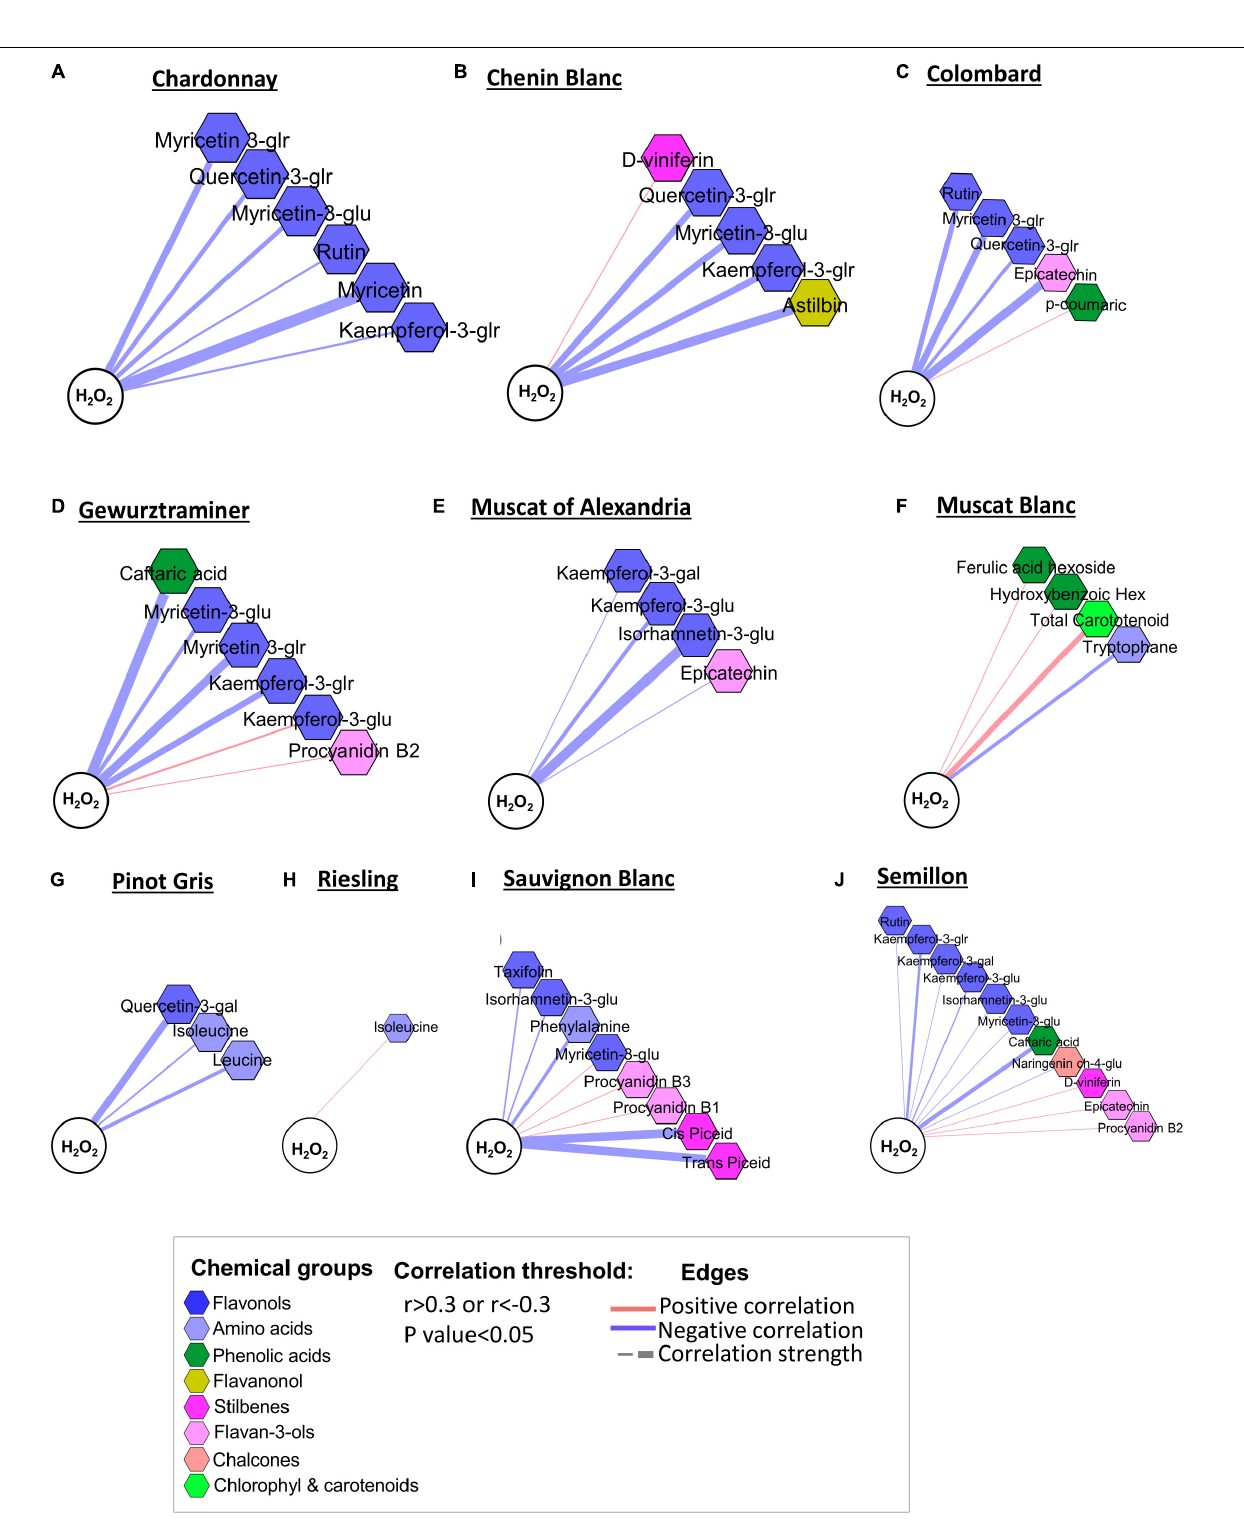
Frontiers in Plant Science |